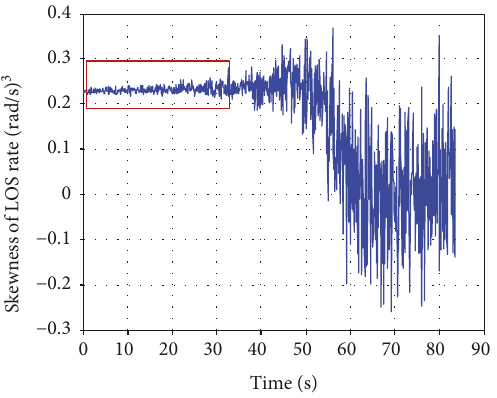
Figure 12: Skewness of the LOS rate (10 times of initial position/velocity error).